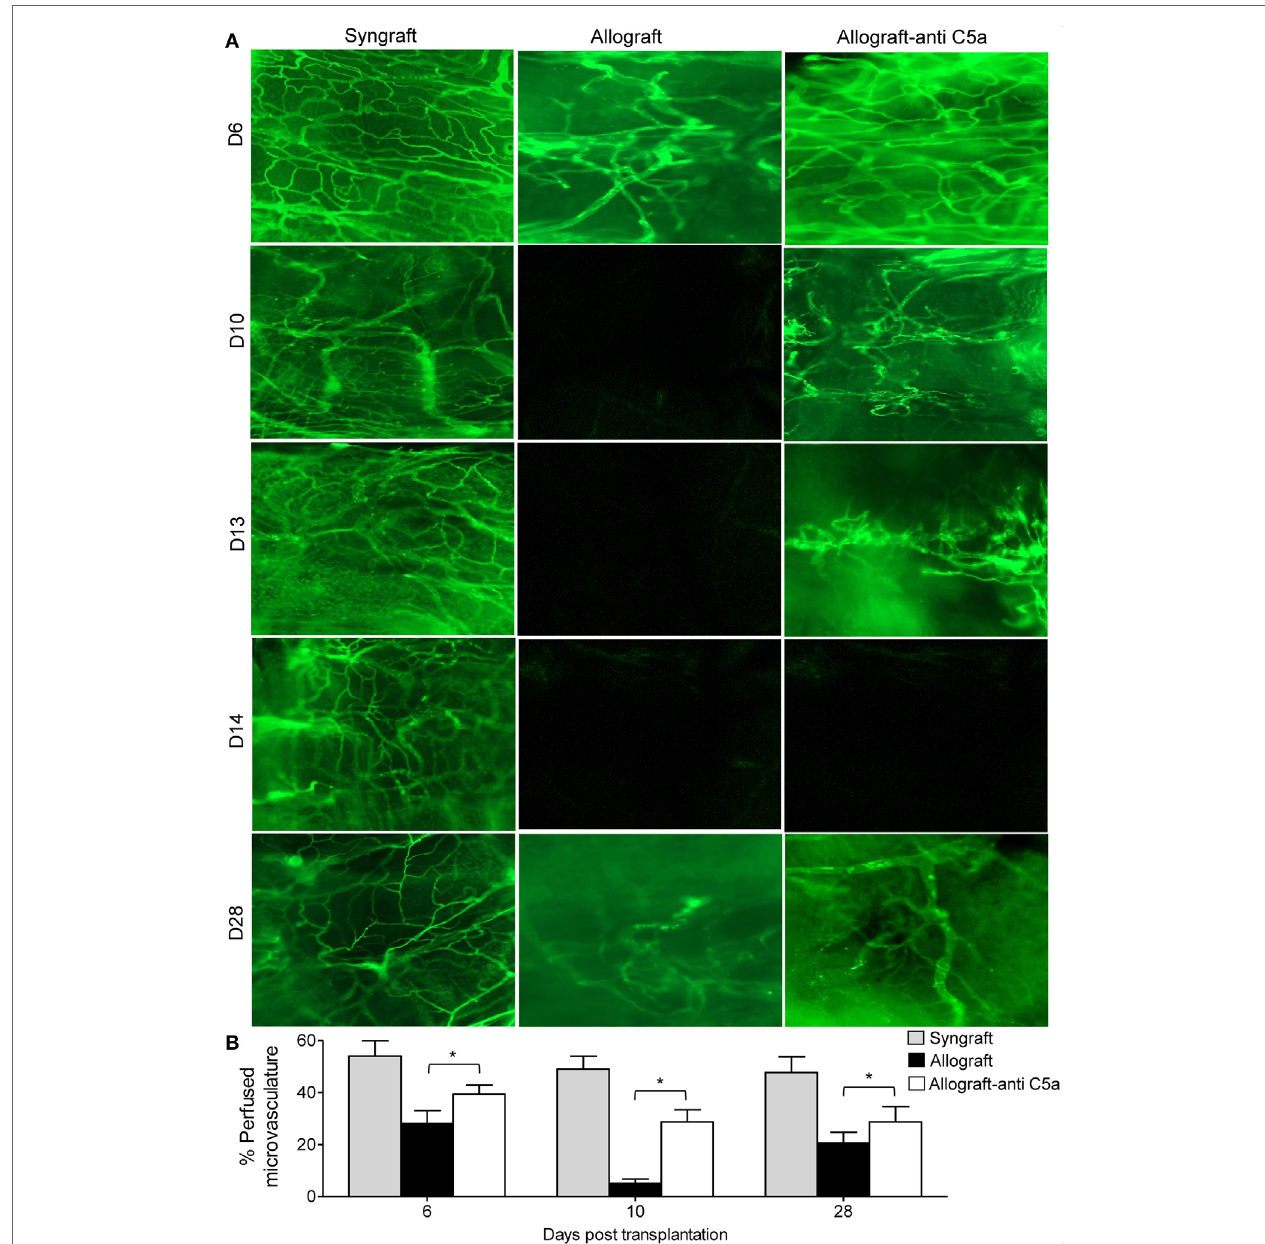
FigUre 3 | C5a blockade preserves donor–recipient microvasculature. (a) Lectin binding assay of whole mount tracheal grafts on d6, d10, d13, d14, and d28. Original magnification, × 20. (B) Morphometric assessment of perfused vasculature (lectin-stained vessels/unit area) in allo-transplanted groups at different time points. Data are presented as means with SE of 4–6 transplants/time point/experiment, and repeats of three different experiments. * p <